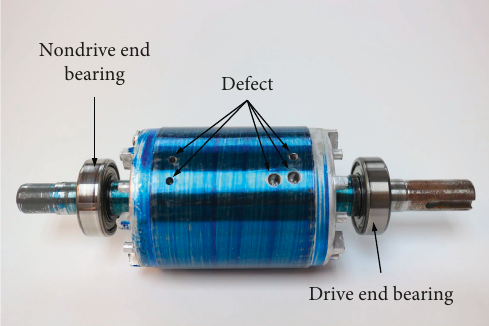
Figure 4: Broken rotor bar (defect created by drilling).